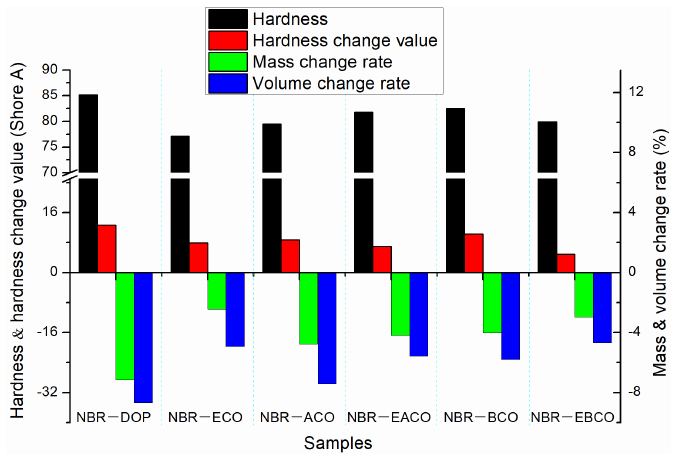
Figure 5. The change in hardness, mass, and volume of NBR vulcanizates after hot oil aging. Table 5. The mechanical properties of NBR vulcanizates after hot oil aging.